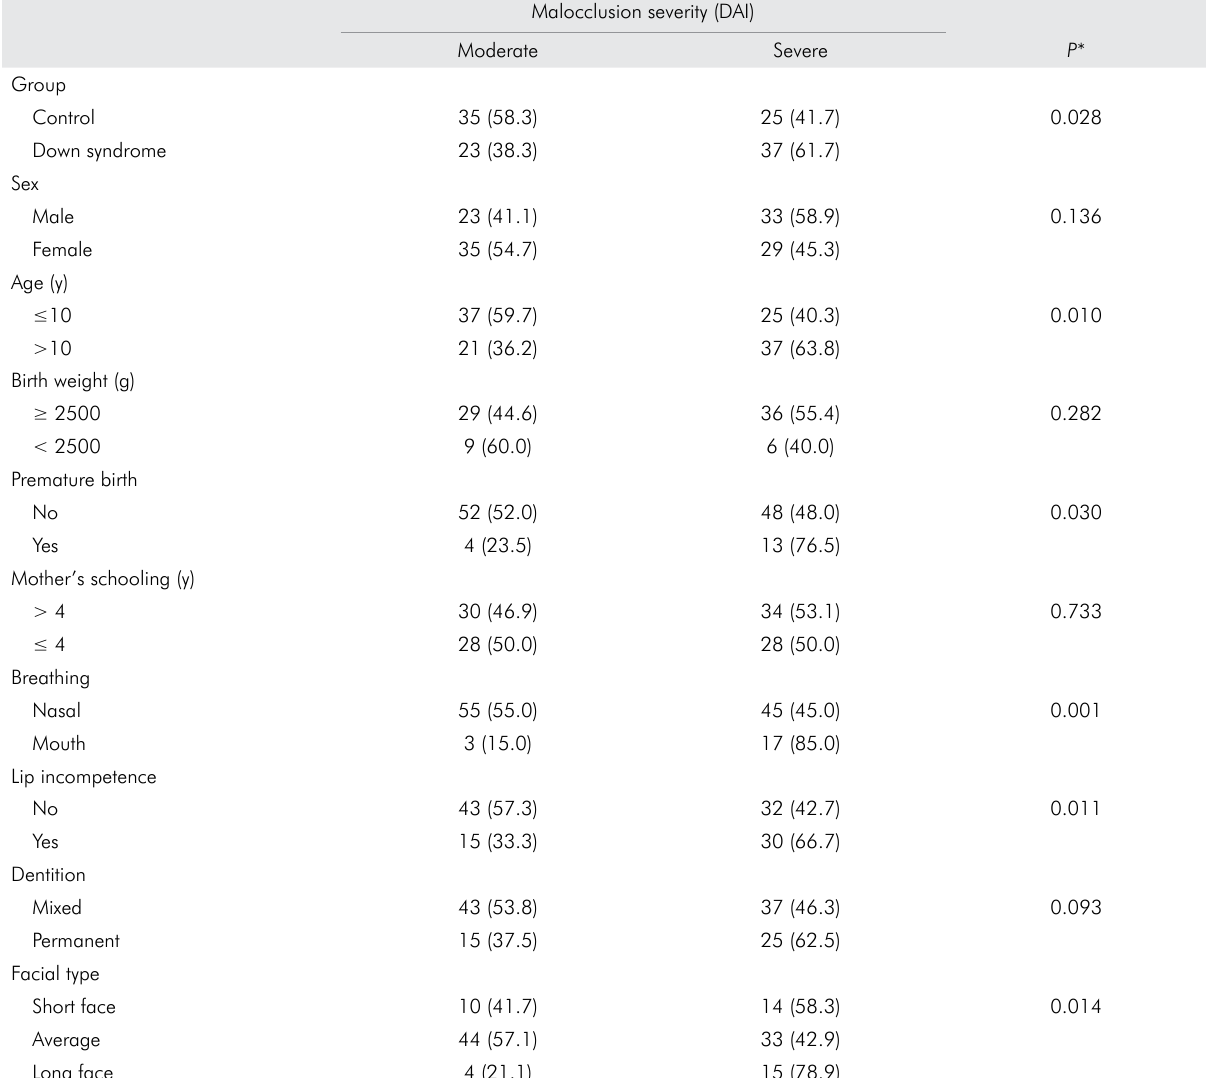
Table 2. Univariate analysis of association between malocclusion severity and individual, social, and behavioral